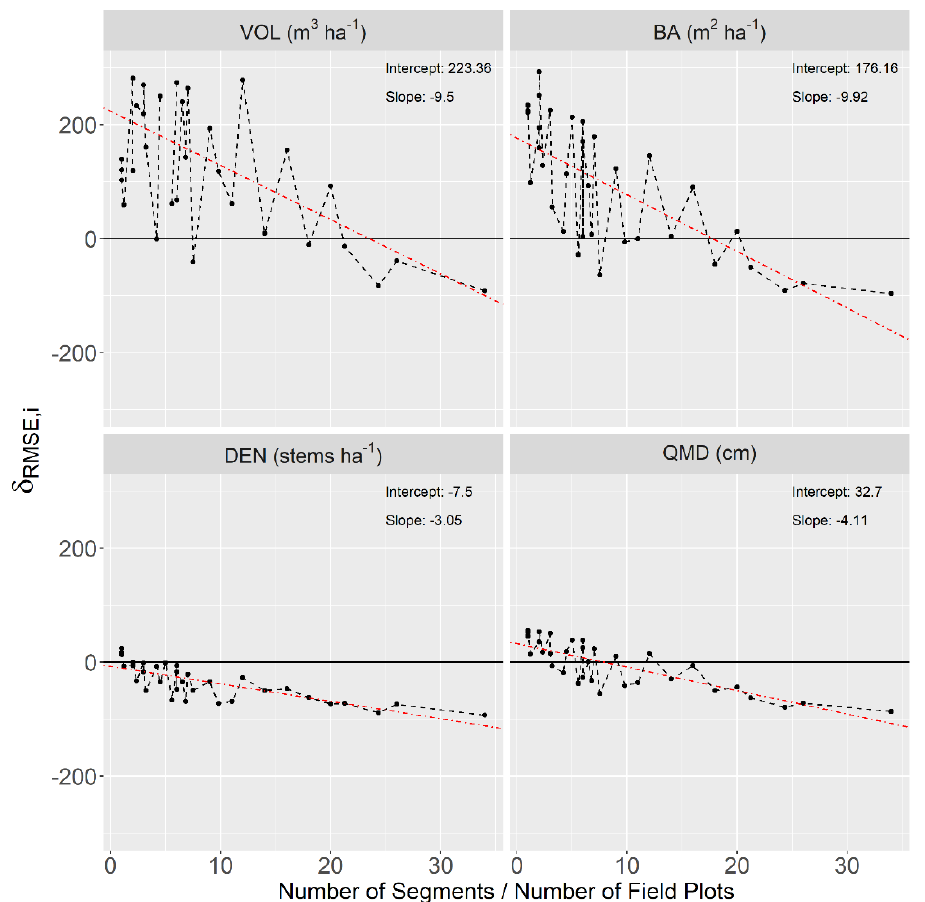
Figure 5 indicates the relative decrease in ˆ RMSE i as it related to an increase in the number of sampled units when going from an ABA model to an s-ITC model. This increase in sample size was expressed as the ratio of the number of segments to the number of field plots for a given stand. Points that fell below the horizontal black line indicated stands where the s-ITC model achieved a smaller ˆ RMSE i than the respective ABA model. This tended to occur in stands where the number of segments was much larger than the number of field plots. We refer to this increase in stand-specific sample size as “segment induced replication.” When segment induced replication was large, the decrease in ˆ RMSE i relative to the ABA model tended to be large. This e ff ect was most clear for DEN and QMD models, with more erratic behavior for the VOL and the BA models. When segment induced replication was small, ˆ RMSE i tended to increase from ABA to s-ITC models for all variables. This e ff ect was most extreme for VOL and BA models.